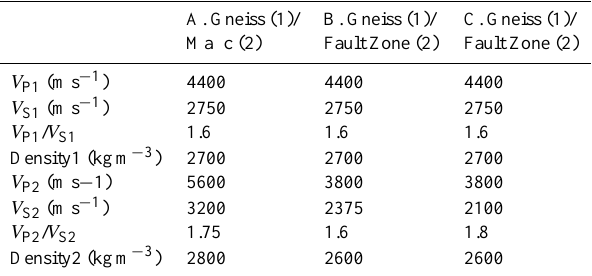
Table 4. Rock parameters used for calculating reflection coeffi- cients. Velocities are typical values from laboratory measurements on rock samples collected along S.P. 2 (A. Nasuti, unpublished data, 2009). The slowest velocity (perpendicular to foliation) was used and the host rock is assumed to be an intact gneiss. Densities are averages from rock samples collected by Biedermann